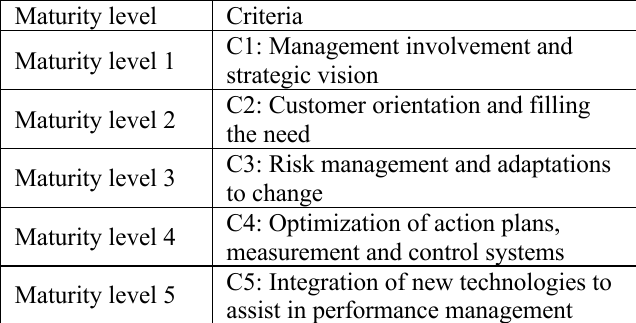
Table 2. Criteria for each maturity